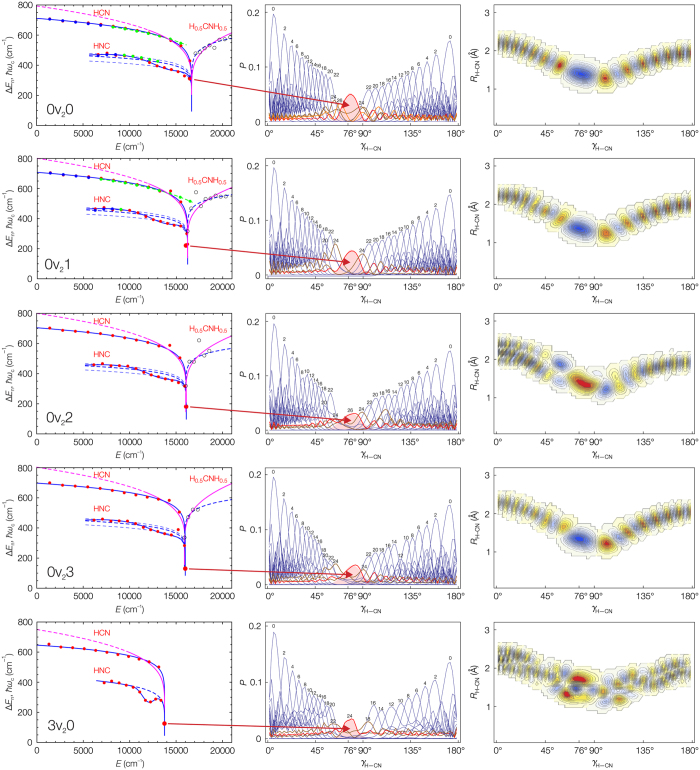
The emergence of the J = 0 saddle point localized states for the [H,C,N] molecular system.Left curves: the quantum frequencies for the bending series of states (red: ab initio data, blue: measured data, green: predicted from measurements) and the analytical models (blue: Equation 7, magenta: Equations 4 and 5). Middle panels: the one-dimensional projection of the wavefunctions on the bending coordinate (red surface: the fitted minimum Gaussian wavepacket probability density curve). Right panels: the two dimensional projection of the wavefunctions for the saddle point localized states. The one dimensional projections show how the harmonic type, single-well bending wavefunctions of HCN and HNC converge to a final saddle point localized state; these states are strongly spatially localized at the γH–CN = 76° transition state. These states correspond to the eigenstates with the smallest quantum frequency and are thus detectable in a spectroscopic experiment. The frequently used two-dimensional representation includes the intensity of the ground state H-CN stretch excitation and shows the localization effect less clearly.